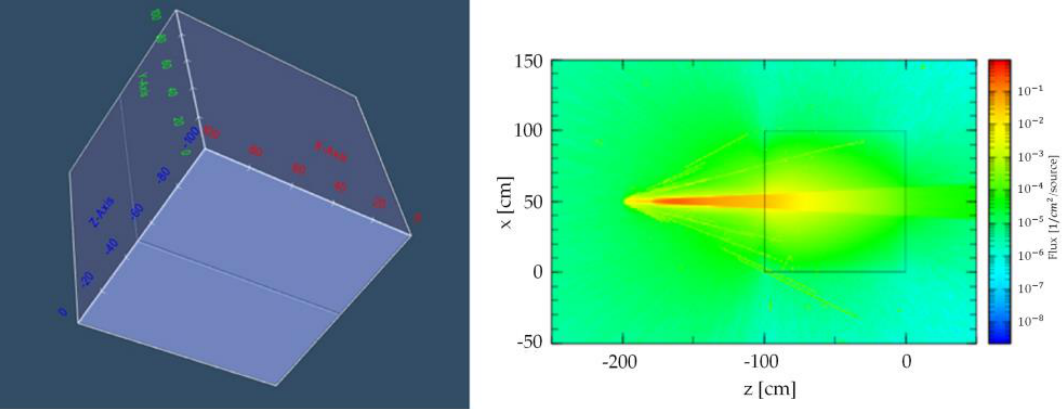
Figure 1. Water phantom and radiation source setup: water with a volume of 1 m 3 was implemented based on Pacific Northwest National Lab material information at an SSD of 100 cm. scheme used in the study was configured as shown in Figure 2.